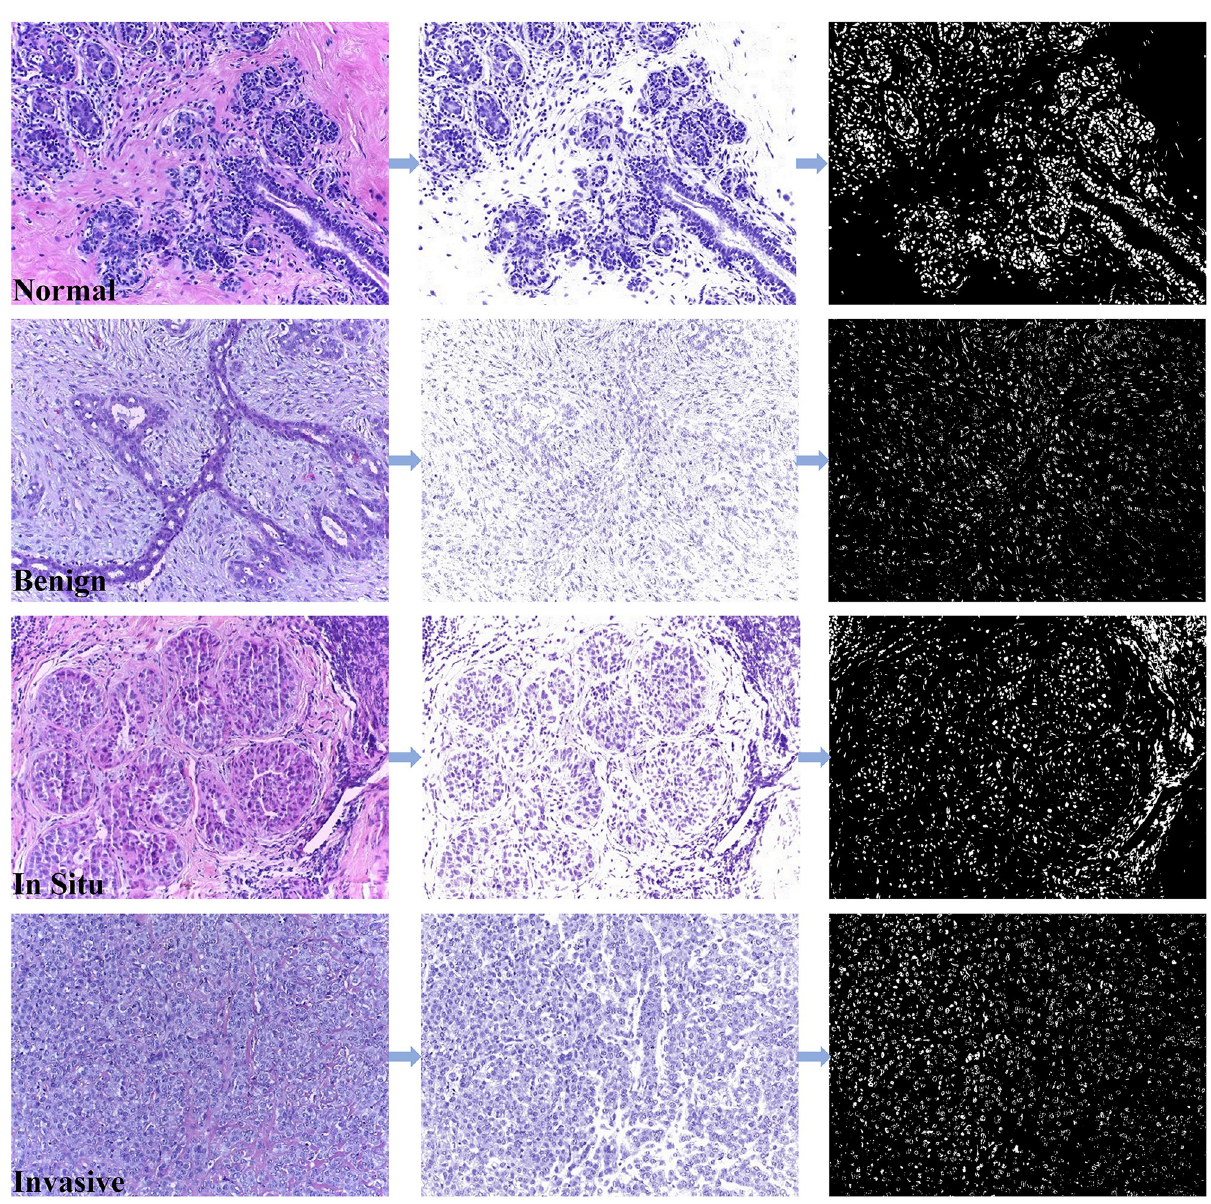
Fig 8. Segmentation results of sample images in bioimaging 2015 dataset based on two-stage nuclei segmentation strategy. (a) the original image, (b) the stain separation image, and (c) the segmented image.